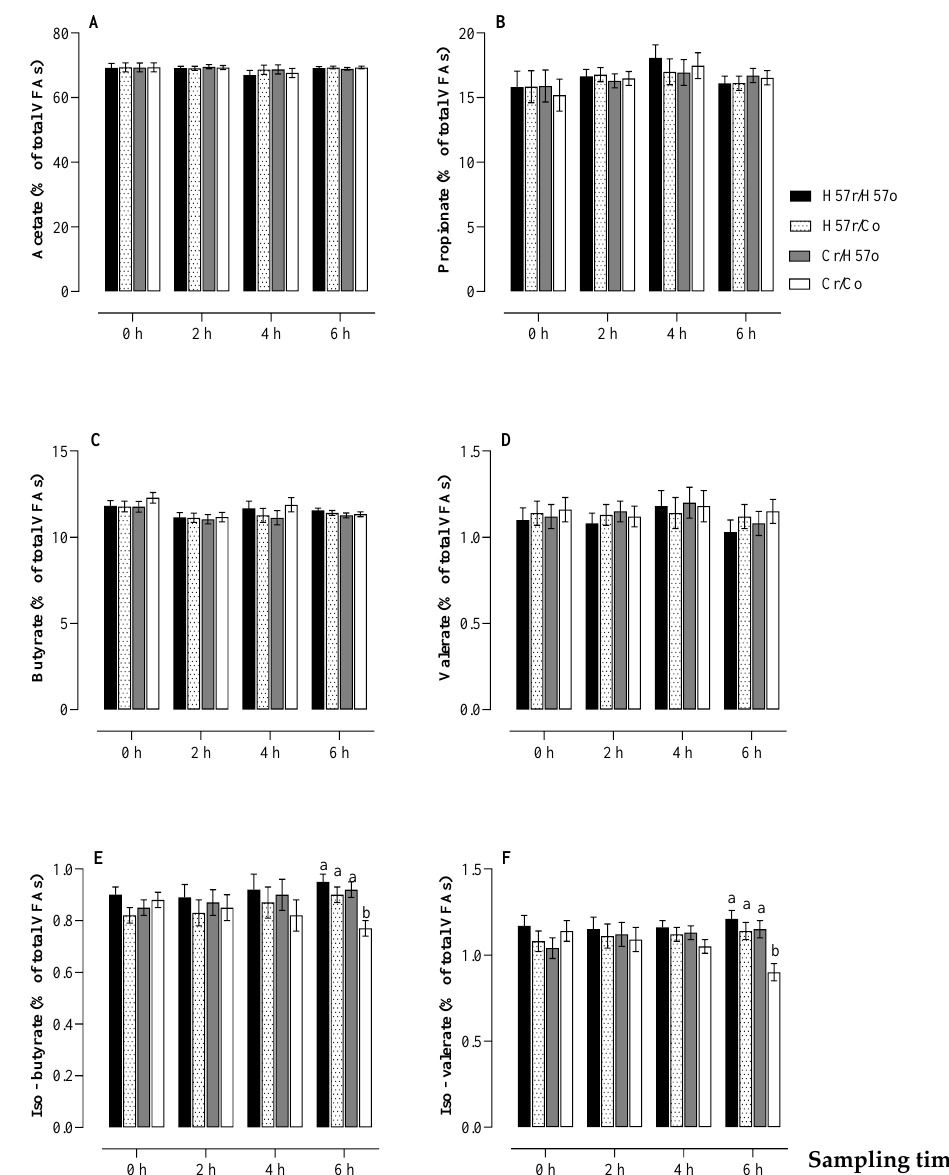
Figure 5. Change in ruminal molar proportions of acetate ( A ), propionate ( B ), butyrate ( C ), valerate ( D ), iso-valerate ( E ) and iso-butyrate ( F ) according to whether H57 or C pellets were ingested orally (o) or through a rumen fistula (r). a, b Values indicate statistical difference between treatments at p < 0.05; error bars represent s.e.m.